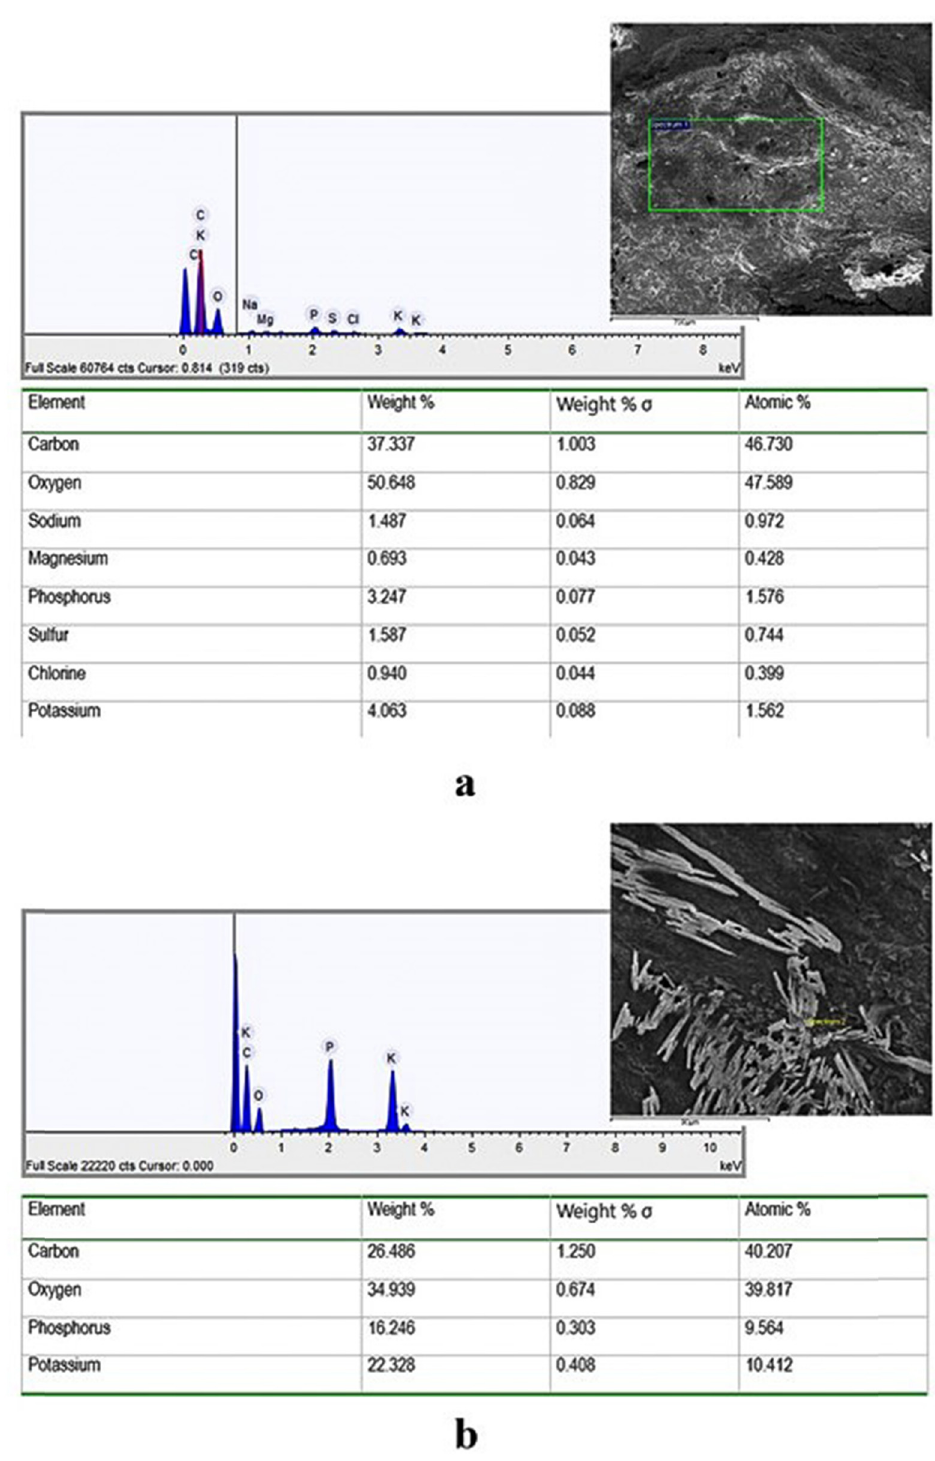
Figure 7: ( a ) 1st point and ( b ) 3rd point, collagen fi